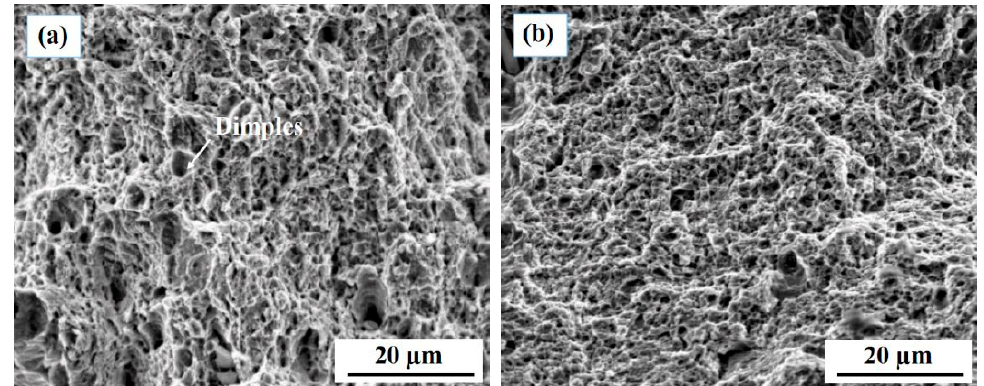
Figure 7. Typical SEM fracture morphologies of samples ( a ) B3 and ( b ) Q&P tested at a strain rate of 500 s − 1 .